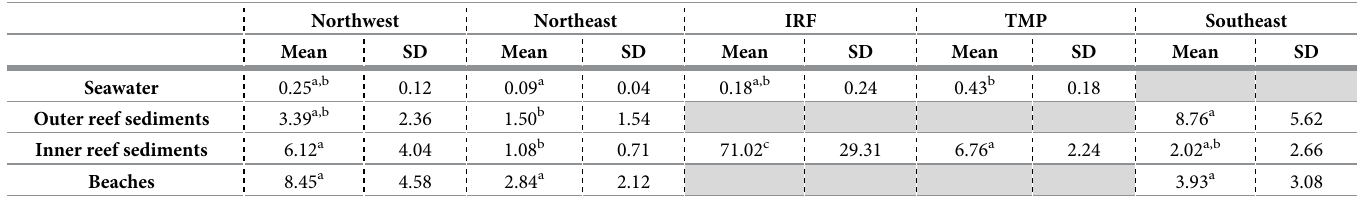
Table 2. Nanoplastic abundance in seawater (particles L -1 ), sediments and beaches (particles g -1 DW) from 5 different sites. Northwest, Northeast, Inner Reef (IRF), wastewater TreatMent Plant (TMP), Southeast. Different letters indicate significant differences among sites (one way ANOVA followed by Tukey’s HSD test): p <